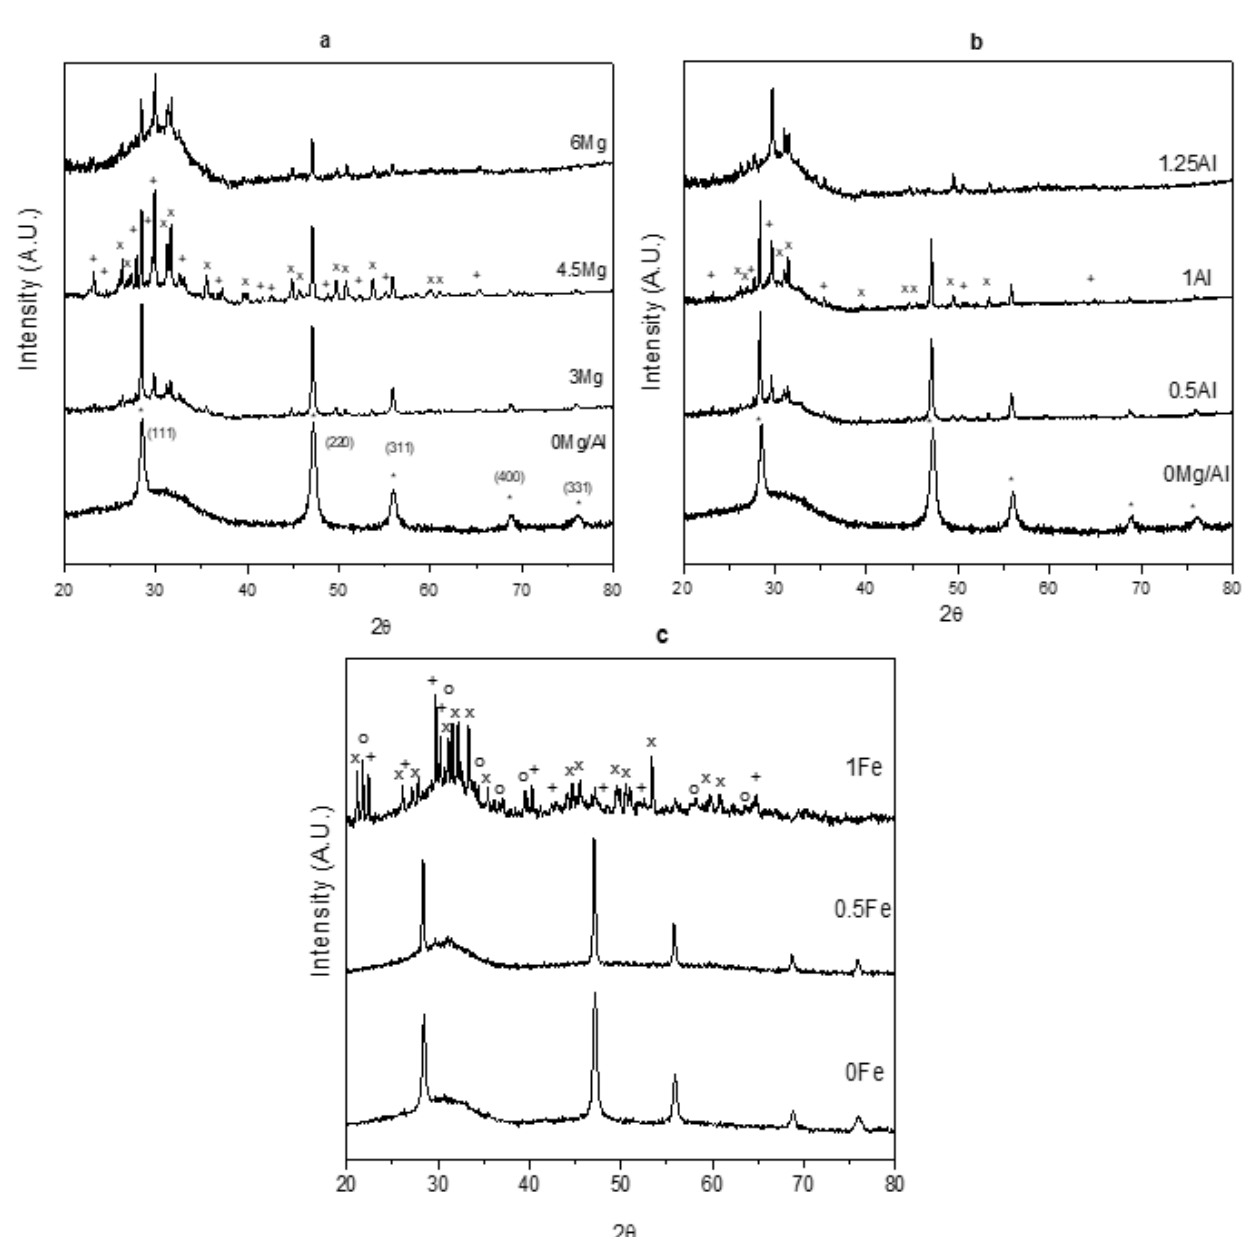
Figure 3. XRD spectra of the investigated glasses heat-treated at (T g + 20 °C) for 17h and at T p for 1h Mg ( a ) Al ( b ) and Fe ( c ) [Peaks correspond to * CaF 2 (ICDD PDF #00-035-0816), + NaPO 3 (ICDD PDF#04-011-3120), x Na 2 Ca 2 (P 2 O 7 )F 2 (ICDD PDF#04-012-1844), o Ca 2 P 2 O 7 (ICDD PDF #00-009-0345)].